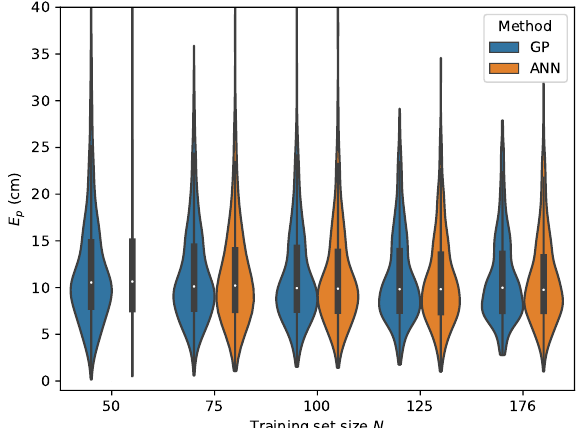
Figure 17. Cross-validation with set D where the r rel , max input features are